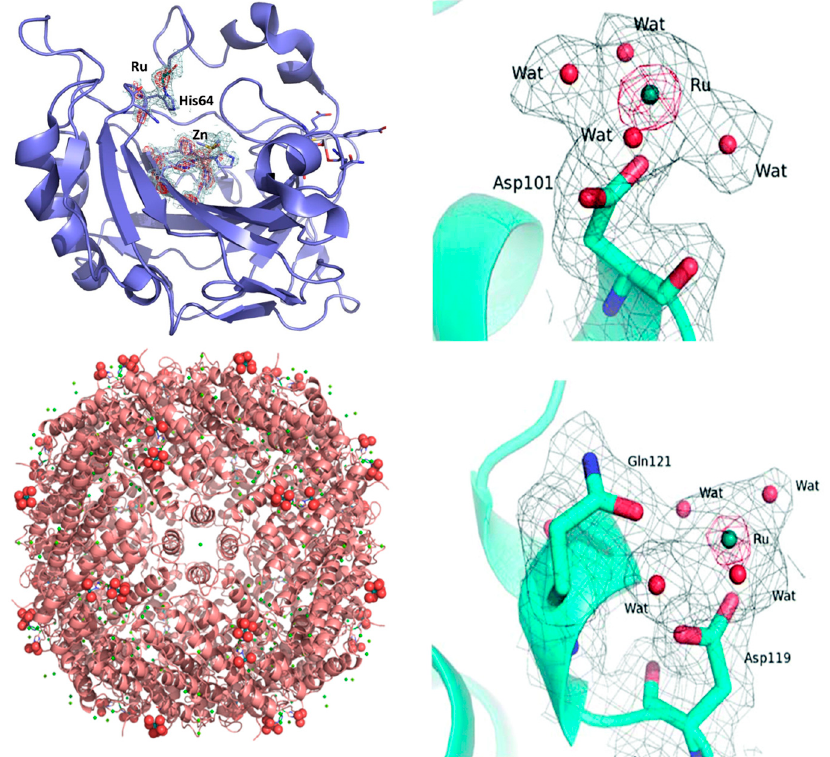
Figure 2. Left: The adduct of NAMI-A with hen egg white lysozyme (HEWL). (top) Ru binding site close to Asp101. (bottom) Ru binding site close to Asp119. Reproduced from Ref. 59 by permission of The Royal Society of Chemistry. Top right: The adduct of NAMI-A with carbonic anhydrase (hCAII). Detail of the Ru center interactions with residues His 64. The oxygen atoms from water molecules are represented as red spheres. Reproduced from Ref. [60] with permission from Elsevier. Bottom right: Ribbon representation of the overall structure of the NAMI-A/HuHf (human ferritin) adduct. The side chain of His105 is shown as a ball and stick, while Ru and the water molecules completing the metal coordination sphere are shown as spheres. Reproduced from Ref. [61] by permission of The Royal Society of Chemistry.